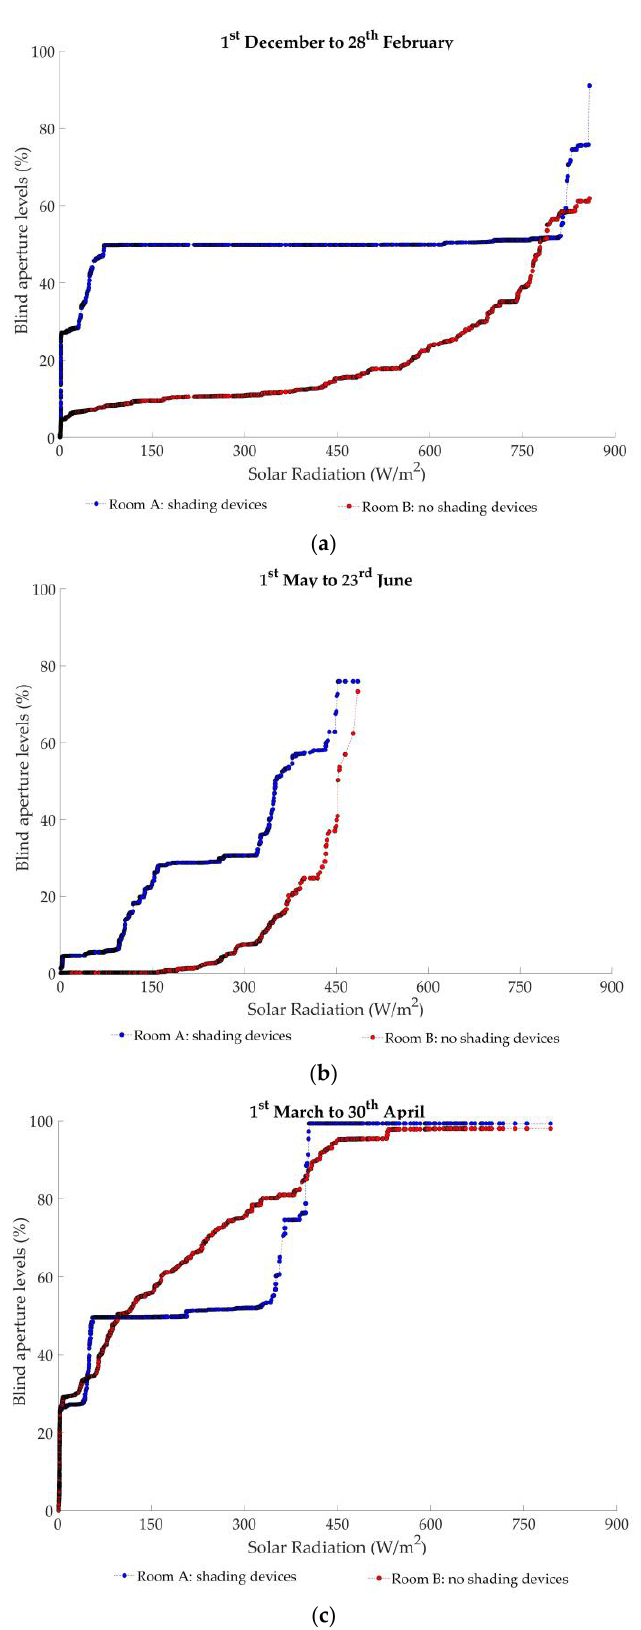
Figure 4. Cumulative distributions of solar radiation levels and blind aperture levels in both rooms for ( a ) winter; ( b ) summer; and ( c ) mid-season.